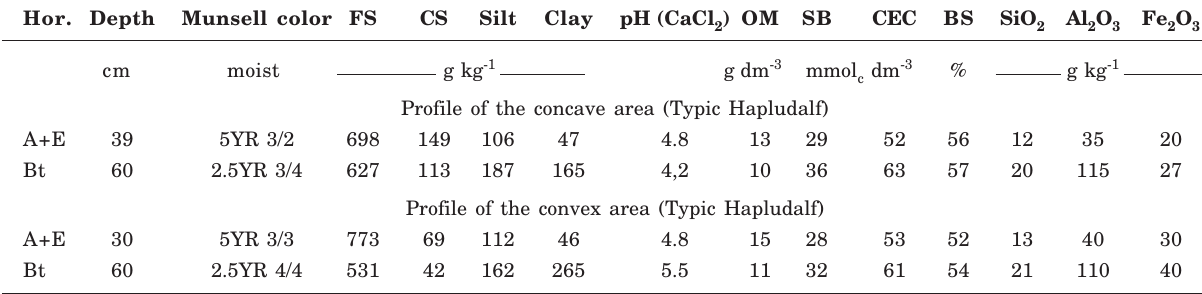
Hor.: horizont; FS: fine sand; CS: coarse sand; OM: organic matter; SB: sum of bases; CEC: cation exchange capacity; BS: base